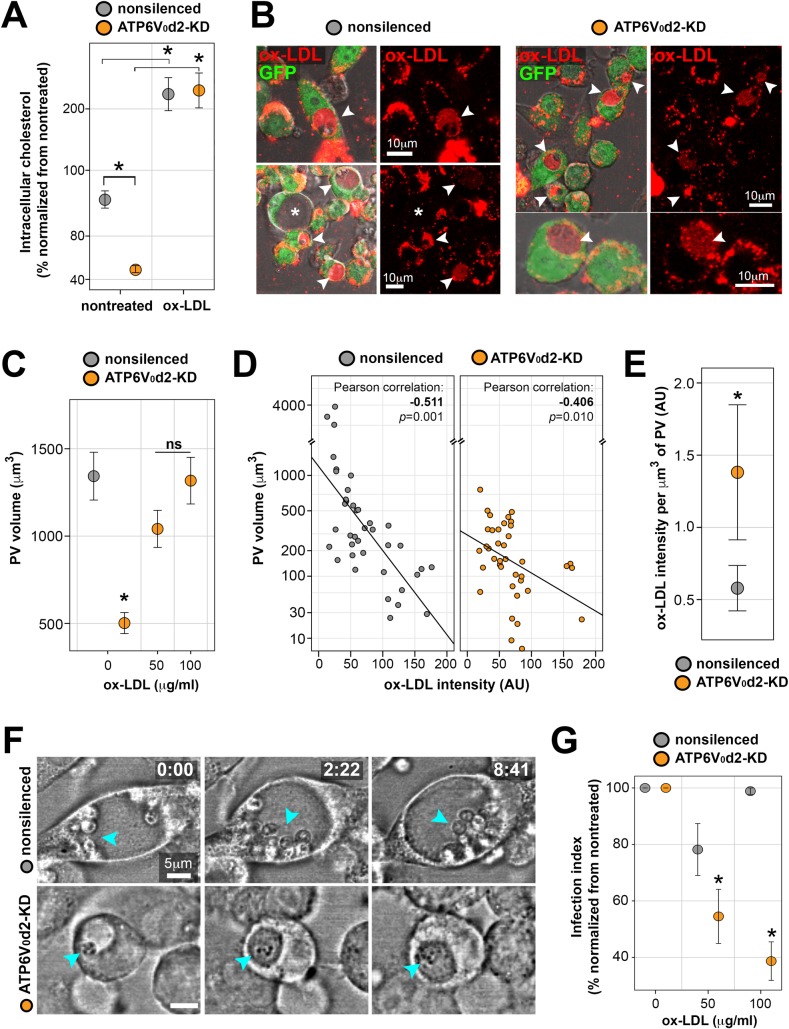
Ox-LDL-mediated repletion of ATP6V0d2-KD cholesterol levels restores PV volumes and impacts parasite multiplication.A. Intracellular cholesterol levels displayed by nonsilenced or ATP6V0d2-KD macrophages treated or not with 50 μg/ml of ox-LDL for 48 hours, showing that ox-LDL replenishes the ~40% lower cholesterol amount of ATP6V0d2-KD to levels comparable to nonsilenced macrophages. The data were normalized by the maximum value obtained in nontreated, nonsilenced macrophage. The asterisks indicate statistical significance (p<0.05), and the results are representative of 4 independent experiments. B. Confocal images of live infected nonsilenced or ATP6V0d2-KD macrophages (green) treated with fluorescent ox-LDL (Dil-ox-LDL). Arrowheads indicate PVs that accumulated ox-LDL and asterisks indicate a representative case in which ox-LDL are not retained in larger PVs. Bar = 10 μm. C. PV volumetric measurements (n = ~50 vacuoles) of ATP6V0d2-KD macrophages infected for 24 hours treated or not with 50 or 100 μg/ml of ox-LDL for the following 48 hours (comprising 72 hours of intracellular infection). The asterisks indicate statistical significance (p<0.05). ns = nonsignificant. The results are representative of 3 independent experiments. D. Correlation between PV volume and fluorescence intensities (in arbitrary units) of Dil-ox-LDL retained in PVs. PV isosurfaces were obtained from Dil-ox-LDL fluorescence signal, allowing for retrieving volumetric data. Larger PVs that do not accumulate ox-LDL were excluded from the correlation. Pearson’s correlation coefficients indicate statistically significant negative correlation between PV volumes and accumulation of ox-LDL in both nonsilenced and ATP6V0d2-KD macrophages. E. Amount of ox-LDL retained in PVs formed in nonsilenced and ATP6V0d2-KD macrophages expressed as Dil-ox-LDL fluorescence per μm3 of PV (* p<0.05). F. Time-lapse imaging in differential interference contrast of infected nonsilenced (upper row) or ATP6V0d2-KD macrophages (lower row) treated with 50 μg/ml ox-LDL. Image acquisition started 24 hours post-infection and 15 minutes after ox-LDL addition; time is represented as hours:minutes (h:mm). In the upper row, arrowheads indicate parasites multiplying in large PVs in nonsilenced macrophages in the presence of ox-LDL; in the lower row, arrowheads indicate parasite killing in PVs whose volume was restored in ox-LDL-treated ATP6V0d2-KD macrophages. Bar = 5 μm. G. Infection index calculated after 72 hours of infection (with or without 48 hours of cholesterol repletion with 50 or 100 μg/ml of ox-LDL) displayed by infected nonsilenced or ATP6V0d2-KD macrophages. Parasite multiplication impairments occurred specifically in ATP6V0d2-KD macrophages in a dose-dependent manner. The data were normalized per macrophage group (nonsilenced or ATP6V0d2-KD) by the maximum value obtained in nontreated macrophages. The asterisks indicate statistical significance (p<0.05) between nonsilenced and ATP6V0d2-KD indexes, and the results are representative of 5 independent experiments.